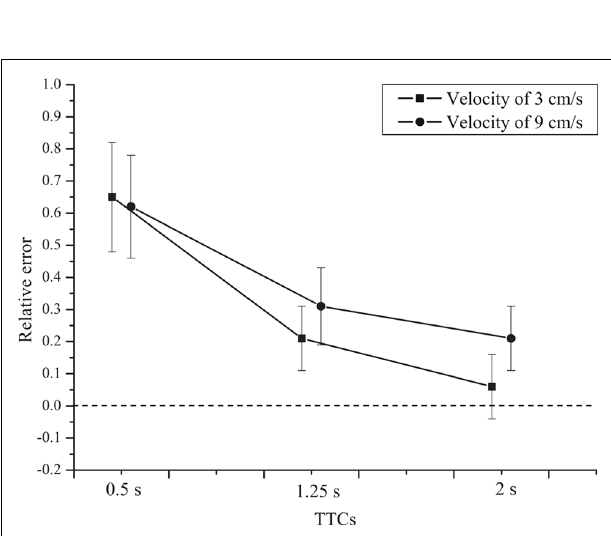
FIGURE 5 | Mean relative error of theTTC estimates, as a function of TTC and velocity. Error bars: 95%